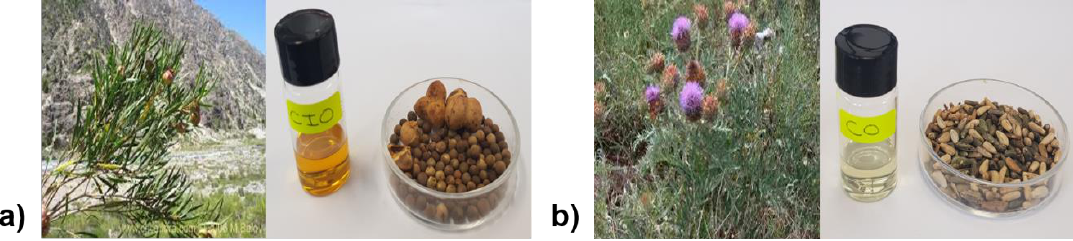
Figure 1. Photograph of plants, obtained oil, and seeds of Colliguaya integerrima (CIO) ( a ), and Cynara cardunculus (CO) ( b ).